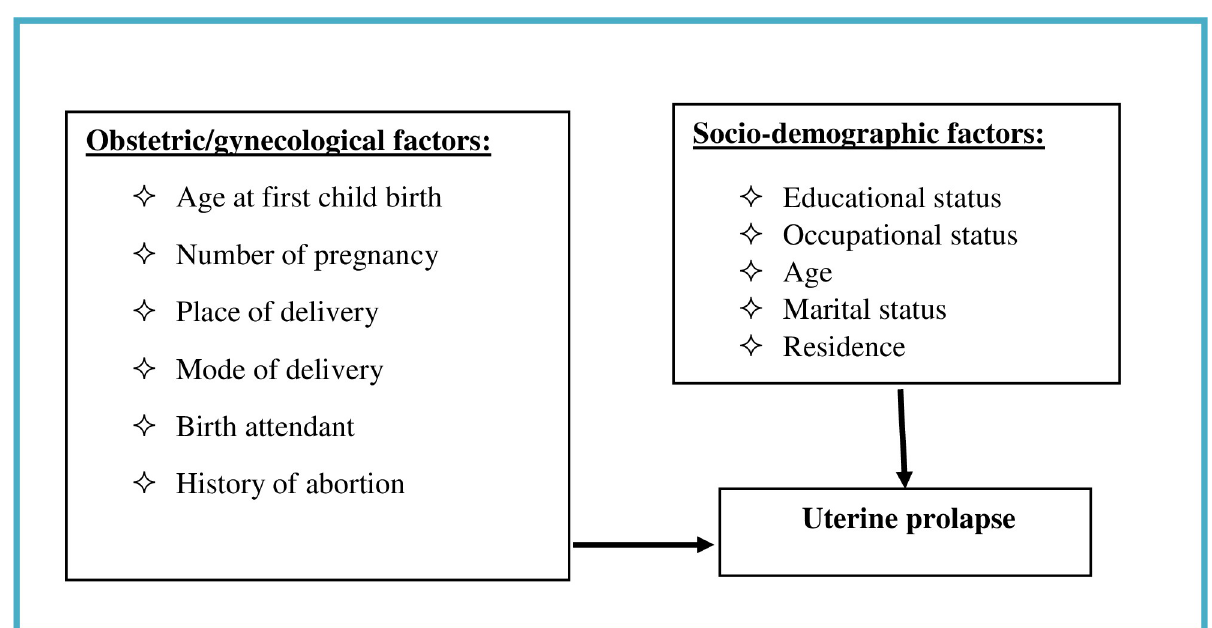
Fig 1. Conceptual framework of the study developed from reviewing the